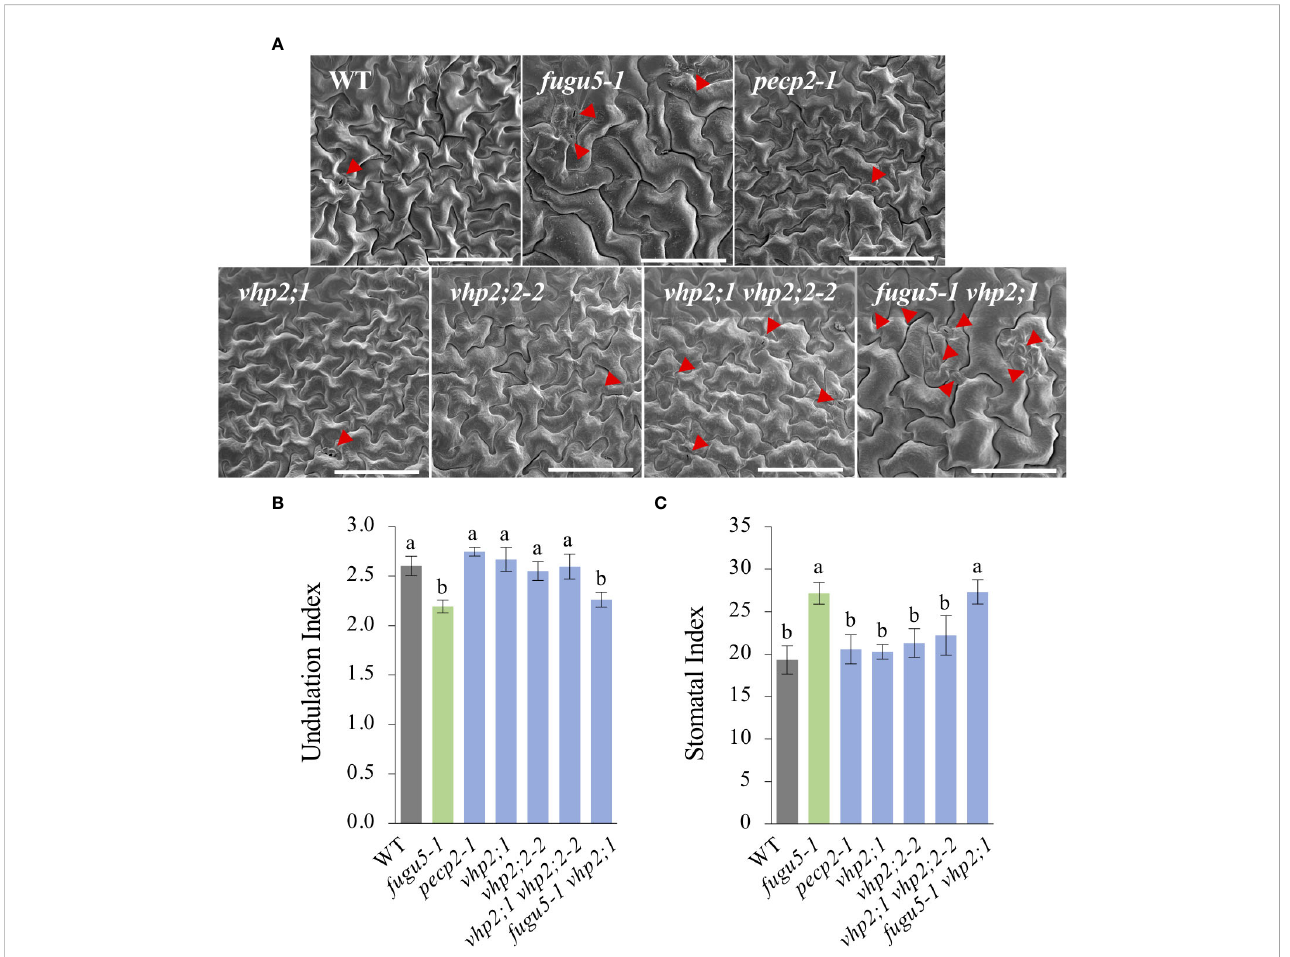
FIGURE 3 Quanti fi cation of pavement cell complexity and stomata distribution on the cotyledon adaxial side. (A) Representative SEM images of pavement cells (PCs) from the cotyledon adaxial side of WT, fugu5-1 , pecp2-1 , vhp2;1 , vhp2;2-2 , vhp2;1 vhp2;2-2 and fugu5-1 vhp2;1 lines at 25 DAS. Red arrowheads indicate stomata. Scale bar = 150 µm. (B) Undulation index (UI) of PCs. Data are means ± SD ( n = 5 cotyledons). (C) Stomatal index (SI) determined as the number of stomata per 100 PCs. Data are means ± SD ( n = 5 cotyledons). Each character represents a signi fi cant difference at P< 0.05 (Tukey ’ s HSD test). DAS, days after seed